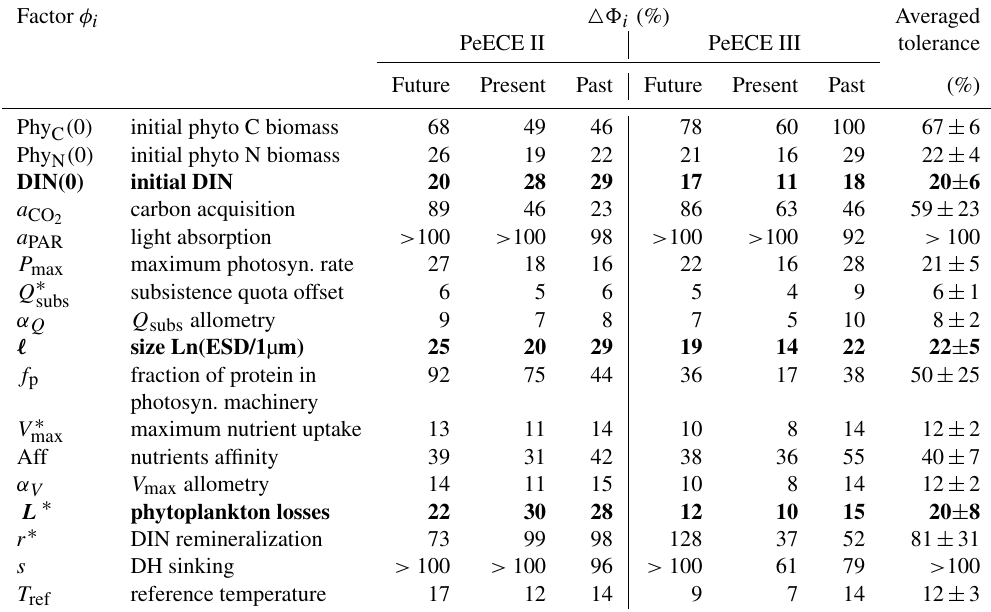
, exceeds the observed i